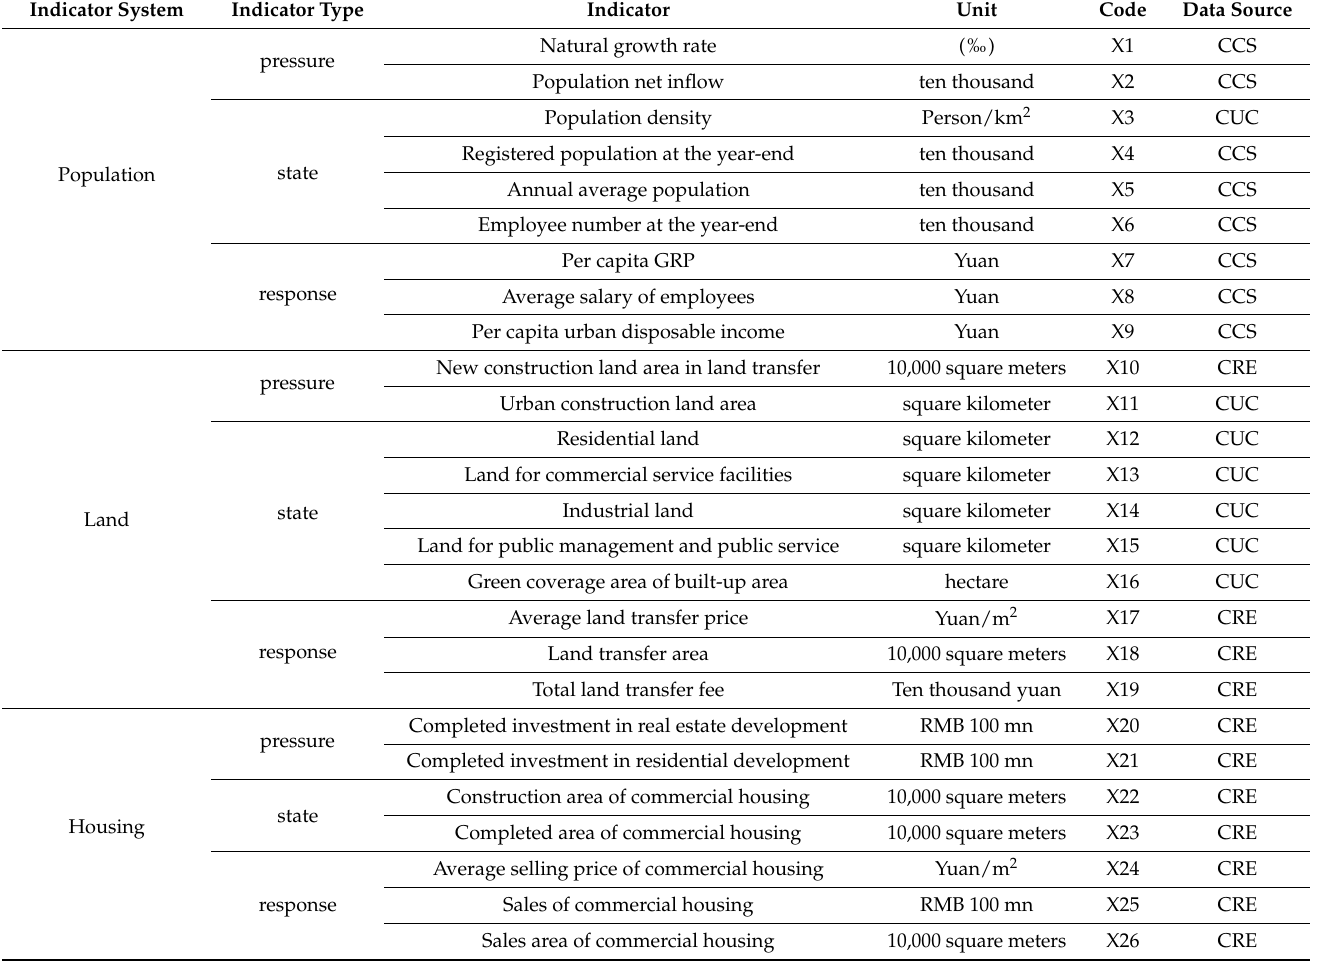
Table 2. Indicator system and data